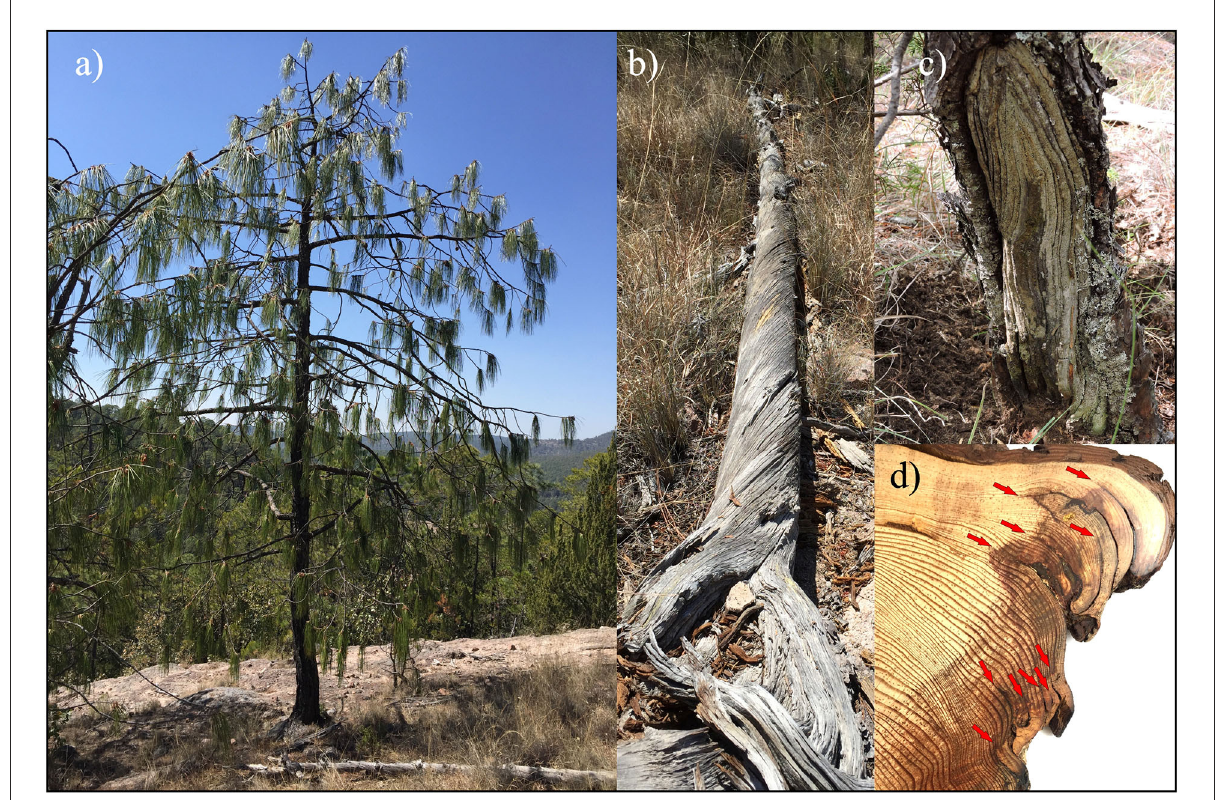
FIGURE2 Field photos of a live Pinus lumholtzii tree growing in rocky soils (A). Fire-scarred samples were collected from a combination of down logs (B) and standing live tree (C). Example of fire-scar sample that has been collected, prepared, and cross-dated using